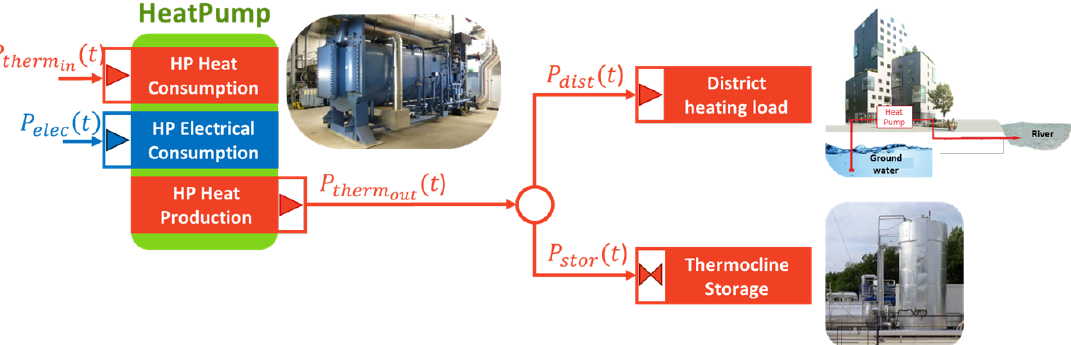
Figure 9. Modeling of the energy system of the first study case (heat pump, district heating load and thermal energy storage) according to OMEGAlpes